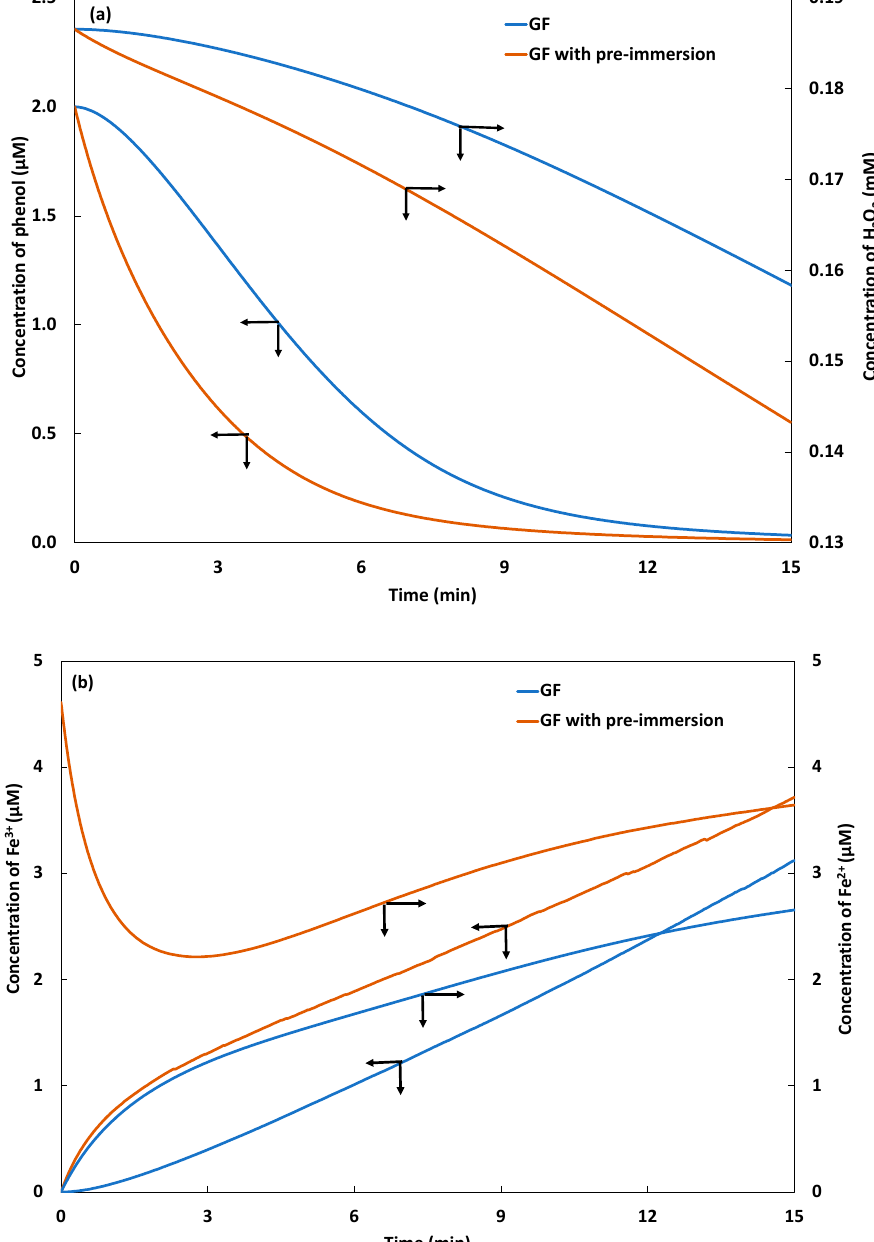
Figure 5. Comparison of Galvano-Fenton and Galvano-Fenton with pre-immersion time in terms of phenol degradation and hydrogen peroxide consumption ( a ) and the evolution of the concentrations of ferrous and ferric ions ( b ).